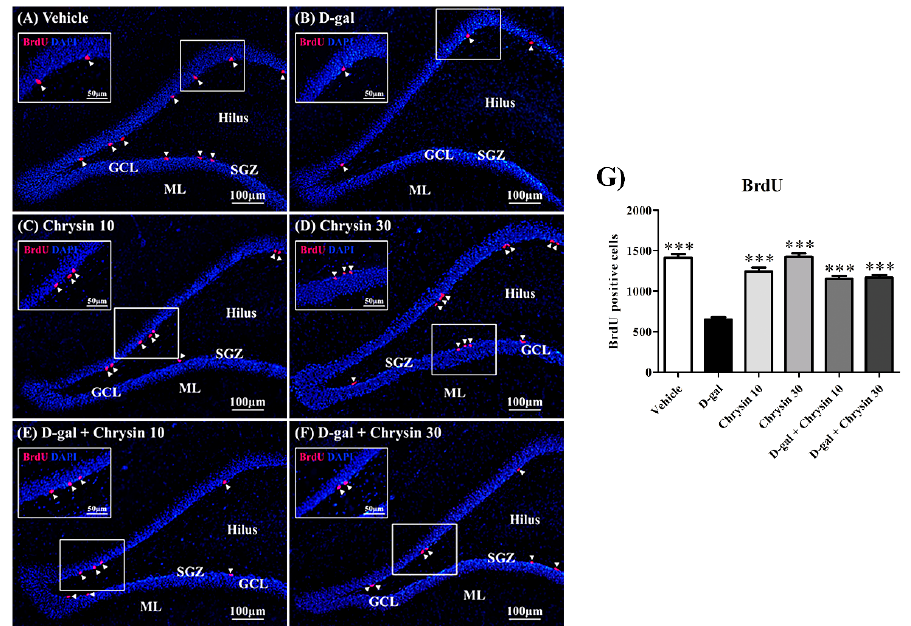
Figure 6. Immunofluorescence staining of all groups ( A – F ). BrdU positive cells (red) are indicated by arrowheads, and all nuclei were counterstained with DAPI (blue). The vehicle, chrysin 10, chrysin 30, and D-gal + chrysin groups had significantly greater numbers of cells stained with BrdU than the D-gal group (*** p < 0.001, G ). SGZ: subgranular zone; GCL: granule cell layer; ML: molecular layer. Nutrients 2020 , 12 , x FOR PEER REVIEW